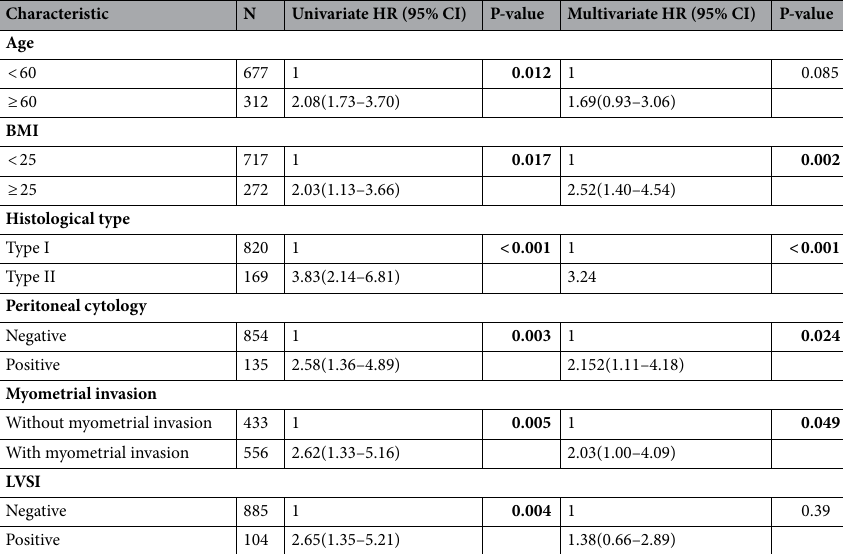
Table 2. Risk factors for recurrence of endometrial carcinoma stage IA (univariate and multivariate analysis). BMI body mass index, LVSI lymphovascular space invasion, CI confidence interval, HR Hazard ratio.